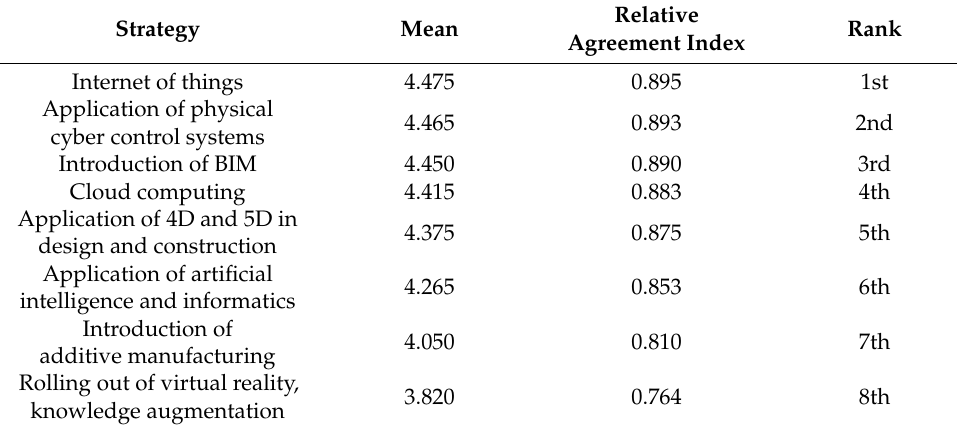
Table 8. Strategies for Achieving the Inclusive Industrial Automation Development Dream through